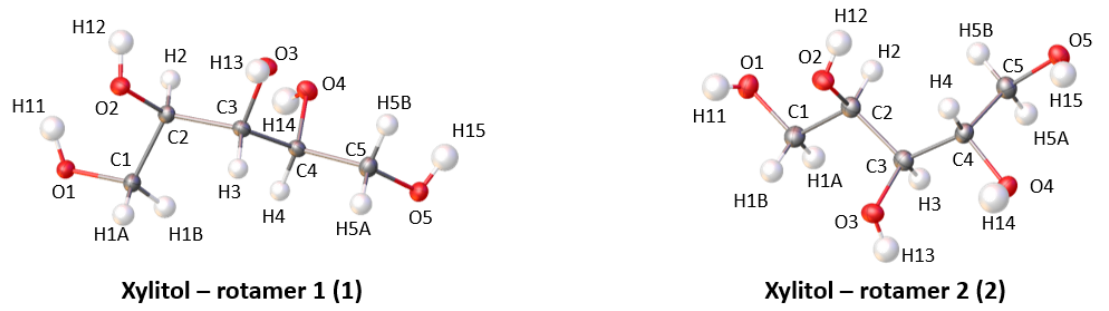
Figure 3. An ORTEP view of rotamers 1 and 2 of xylitol. Displacement ellipsoids are drawn at 50% probability level.